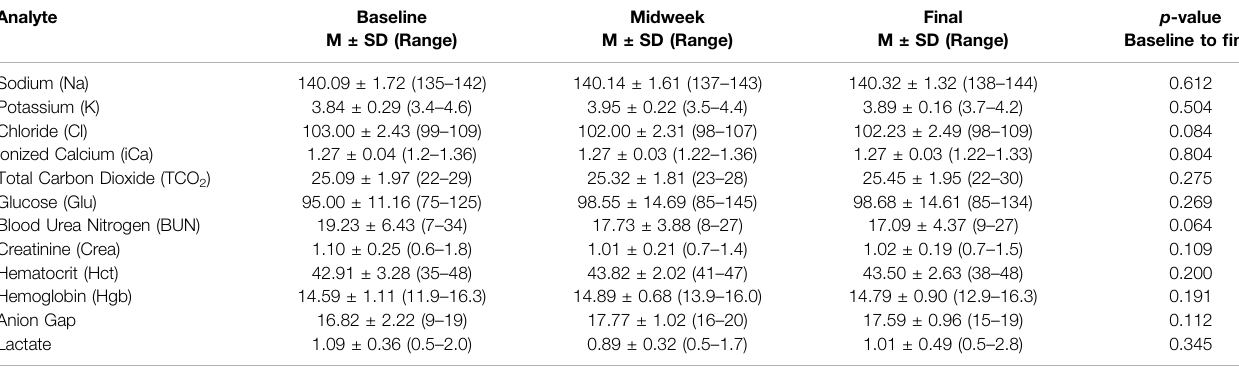
TABLE 3 | Blood chemistry. Venous blood chemistry measurements reveal no change in the levels of 12 analytes measured at baseline, midweek, and study endpoint. All p -values are from repeated measures linear mixed model with compound symmetric covariance structure analysis.